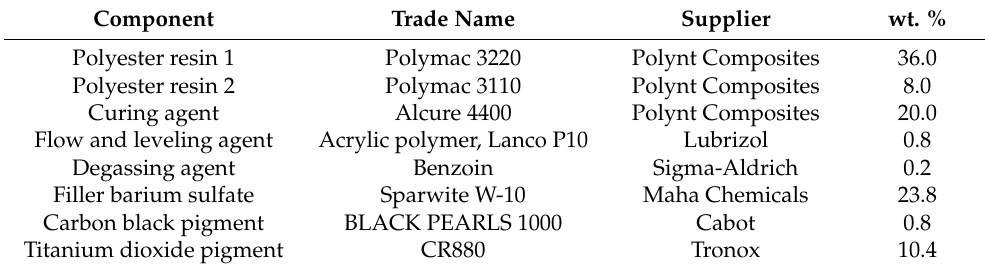
Table 3. Formula 3—grey polyurethane powder coating.